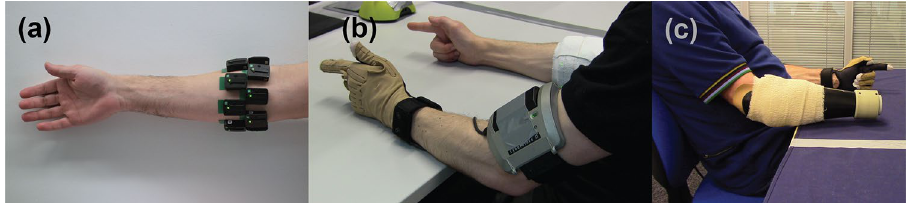
Figure 5. Data collection. ( a ) Sixteen wireless EMG sensors were placed on the surface of the skin and were arranged in two rows of eight equidistant sensors below the elbow. ( b – c ) Hand kinematic data were collected using an instrumented data glove placed on the contralateral side. Participants were instructed to perform bilateral mirrored movements. Parts of the figure were previously published by us under a Creat ive Commo ns Attri bute Licen se (CC BY 4.0) 21